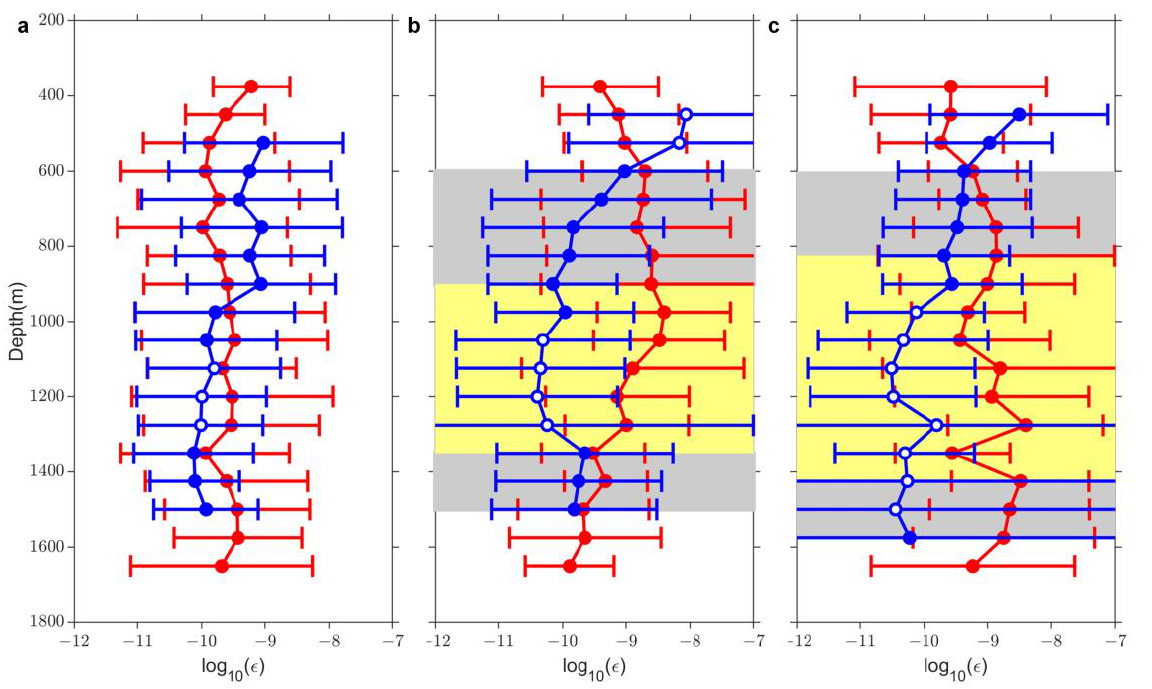
Figure 6. Turbulent dissipation rates estimated from CTD/LADCP and seismic data using meas-ured R ω . The blue and red lines represent the seismic data and CTD/LADCP measurements, respec-tively. Hollow dots represent ε from interpolation (seismic boxes without reflector inside), while solid dots represent the normal ε estimated from seismic reflectors. The grey background repre-sents the top and bottom edges of the meddy. The shallow yellow represents the core of the meddy. The horizontal bars represent the 95% CI uncertainty levels. ( a ) At cast 35. ( b ) At cast 36. ( c ) At cast 37. The location of CTD can be found in Figure 7a.